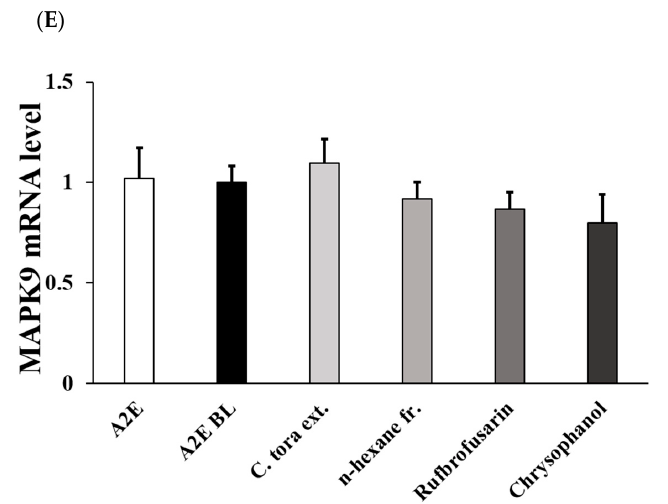
Figure 5. mRNA expressions related to apoptosis pathway in each group using RT-PCR. The effects of Cassia tora seed extract, fractionation, and compounds on apoptosis-associated mRNA expression of ABL1 ( A ), TP53 ( B ), MAPK14 ( C ), MAPK8 ( D ), and MAPK9 ( E ) in blue-light-induced A2E-loaded ARPE-19 cells were observed. Values are mean ± SEM of three independent experiments performed at different times. * p < 0.05, and *** p < 0.001 vs. A2E blue light group; ### p < 0.001, and ## p < 0.01 positive control vs. A2E blue light group. RT-PCR, real-time polymerase chain reaction; ABL1, ABL proto-oncogene 1, non-receptor tyrosine kinase; TTP53, TTP53 tumor protein TP53; MAPK8, mitogen-activated protein kinase 8; MAPK9, mitogen-activated protein kinase 9; MAPK14, mitogen-activated protein kinase 14; GAPDH, glyceraldehyde-3-phosphate dehydrogenase; SEM, standard error of mean.